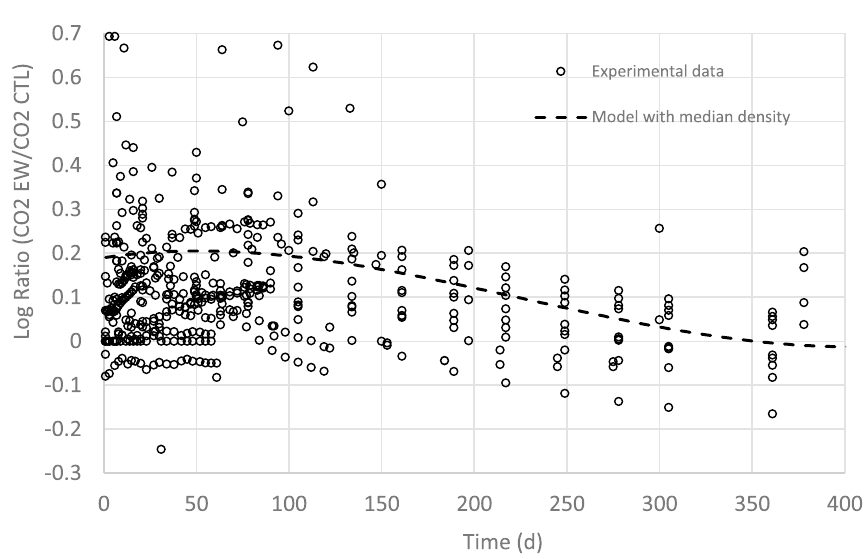
Figure 4. Comparison between all the experimental data and the simulated results of the logarithm ratio of CO 2 emissions with EW and without EW as a function of time and earthworm density for the 42 experiments. Simulations were carried out with the best model based on random temporal effects and fixed EW density effects (see the equation, parameters and statistical parameters given in Table 2). The median EW density of our experimental set (median Exp. = 1.95 mg EW/g dry soil) was